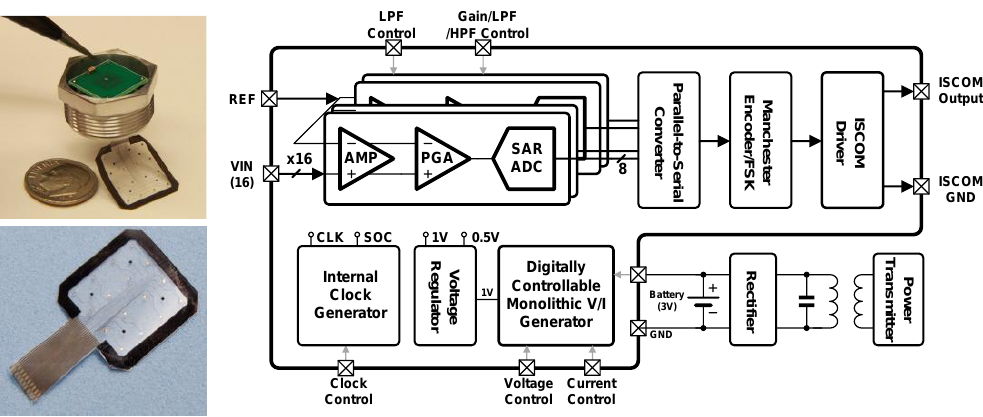
Figure 2. Photograph of the fabricated neural interface module and the flexible microelectrode array ( left ), the block diagram of integrated circuits in the module ( right ).